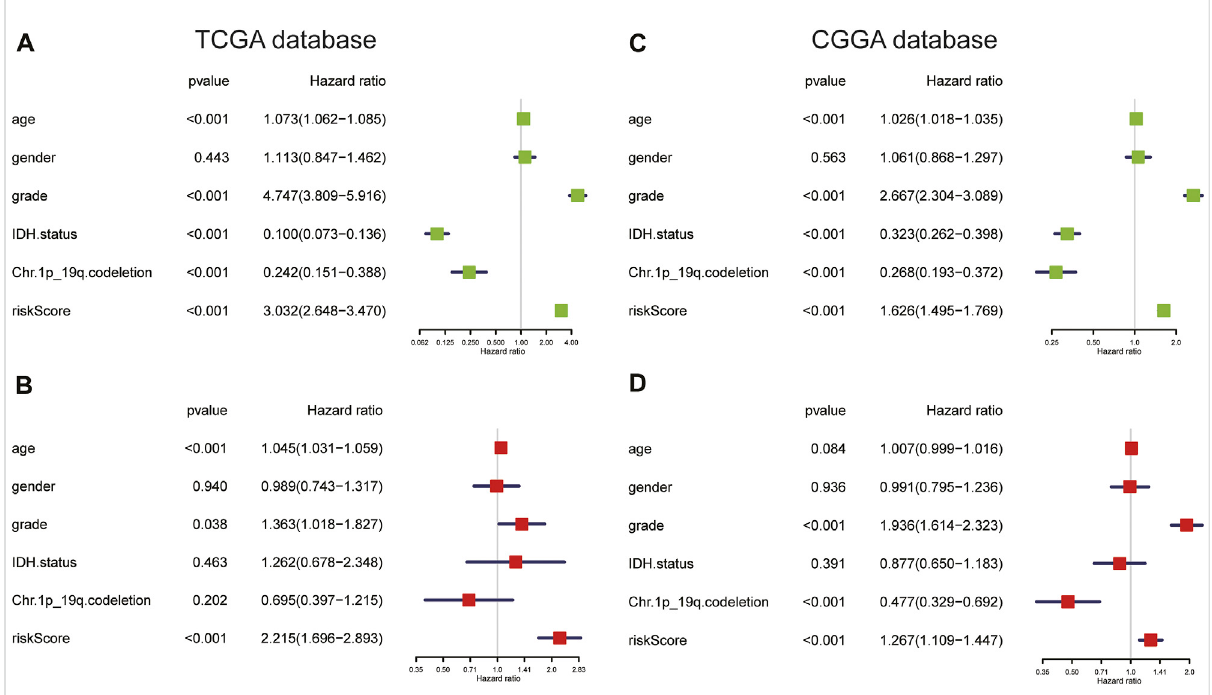
FIGURE 7 (A,B) Univariate and multivariate Cox regression analyses in the TCGA cohort. (C,D) Univariate and multivariate Cox regression analyses of clinicopathologic features in the CGGA